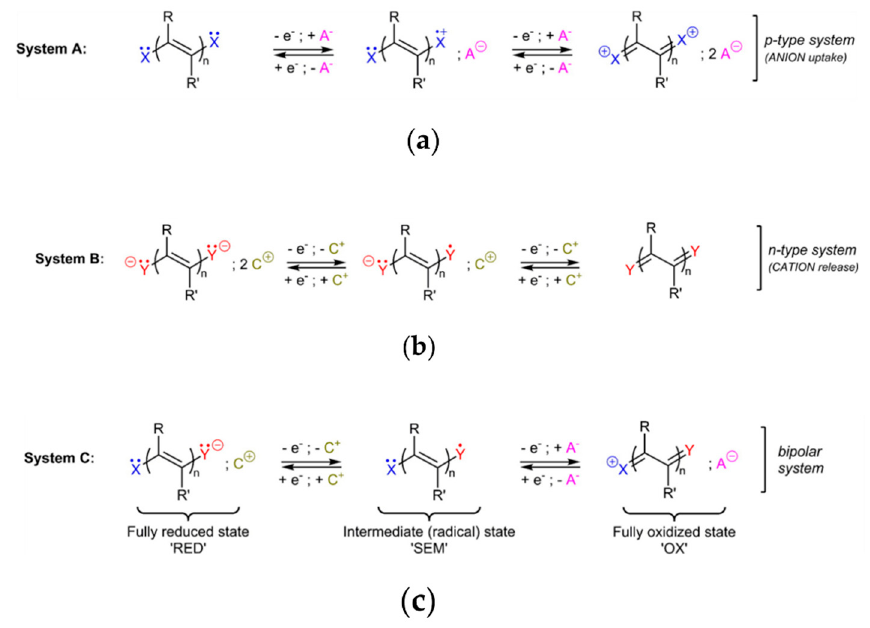
Figure 6. (a-c) 3 general key redox-active organic systems and their related charge transfer steps (adapted from Hünig’s classification (adapted from Hünig’s classification [104]).